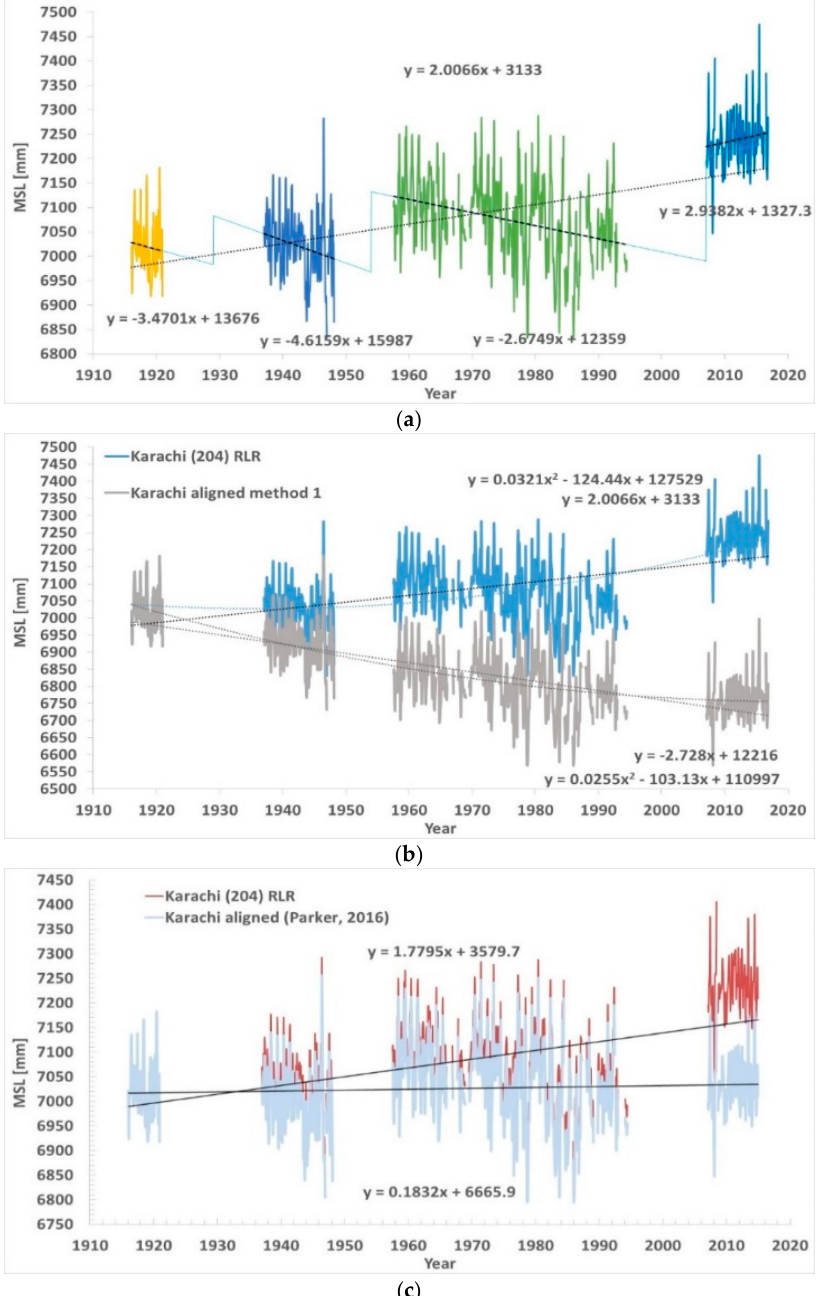
Figure 7. Karachi. ( a ) Linear fittings applied to the four segments. ( b ) MSL aligned compared to the PSMSL RLR data. ( c ) MSL aligned with the same method, but only three segments, as in [3], compared to the PSMSL RLR data. When measured, the sea levels were decreasing. The rising trend of the PSMSL RLR data is the result of the shifts of one segment versus the other, always upwards versus the values suggested by the alignment of the breakpoints.